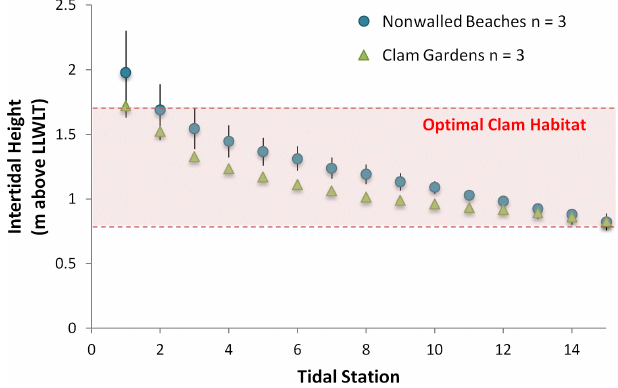
Fig. 4 . Intertidal height of our 15 tidal stations where clams were surveyed from 25 x 25 x 25 cm samples at 3 ancient clam gardens (green) and 3 nonwalled clam beaches (blue) in Kwakshua Channel, British Columbia, Canada. LLWLT = lowest low water large